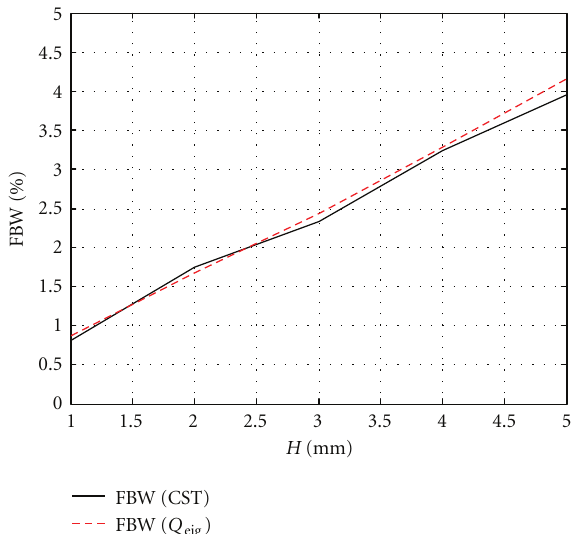
Figure 10: The first two characteristic modes (currents and charges) for the SAU2 structure.